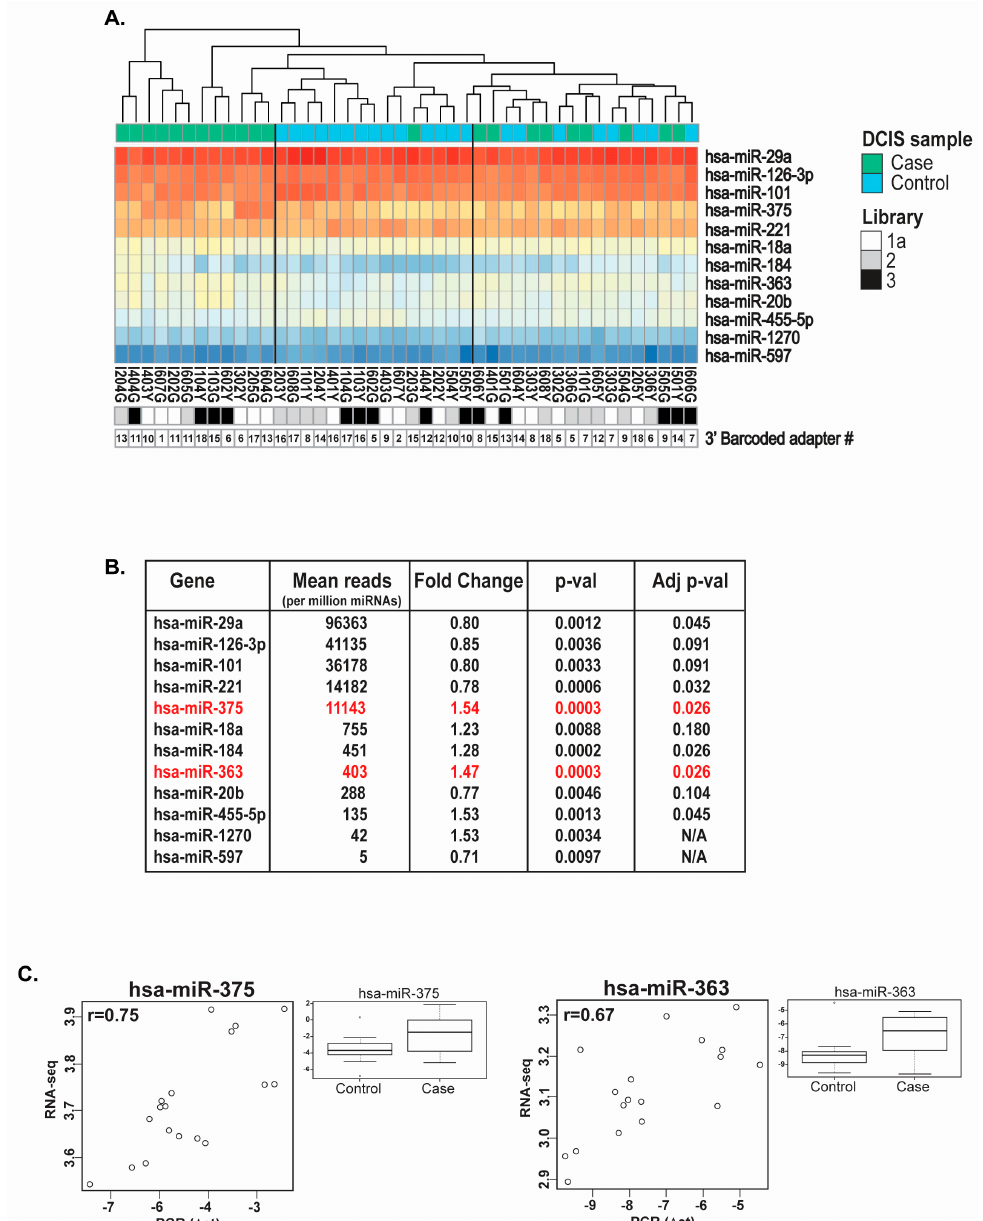
Figure 5. miRNAs differentially expressed in DCIS lesions based on case-control status. ( A ) Unsupervised clustering of DCIS cases ( n = 22) and controls ( n = 22) and heat map representation of the top 12 differentially-expressed miRNAs; ( B ) Statistical analysis on the top 12 differentially-expressed miRNAs (normalized mean of count reads (base mean), fold change difference (Log2FC), p -value ( p -value) and adjusted p -value (Adj pval)). The two miRNAs selected for qPCR validation are highlighted in red; ( C ) Non-parametric Spearman rank correlation between quantitative PCR data of miR-375 and miR-363 in nine matched case-control DCIS specimens and miRNA sequencing data (the r -value represents the correlation). Two endogenous controls (mean of the comparative threshold measured for small-nucleolar RNAs (RNU44 and RNU6B) were used to normalize miRNA qPCR data. The box plot graphs display the variance stabilizing transformation (vst, DESeq2 package) for the expression of miR-375 and miR-363 in the two groups (cases and controls), with the p -value on differential expression between nine cases and nine controls.